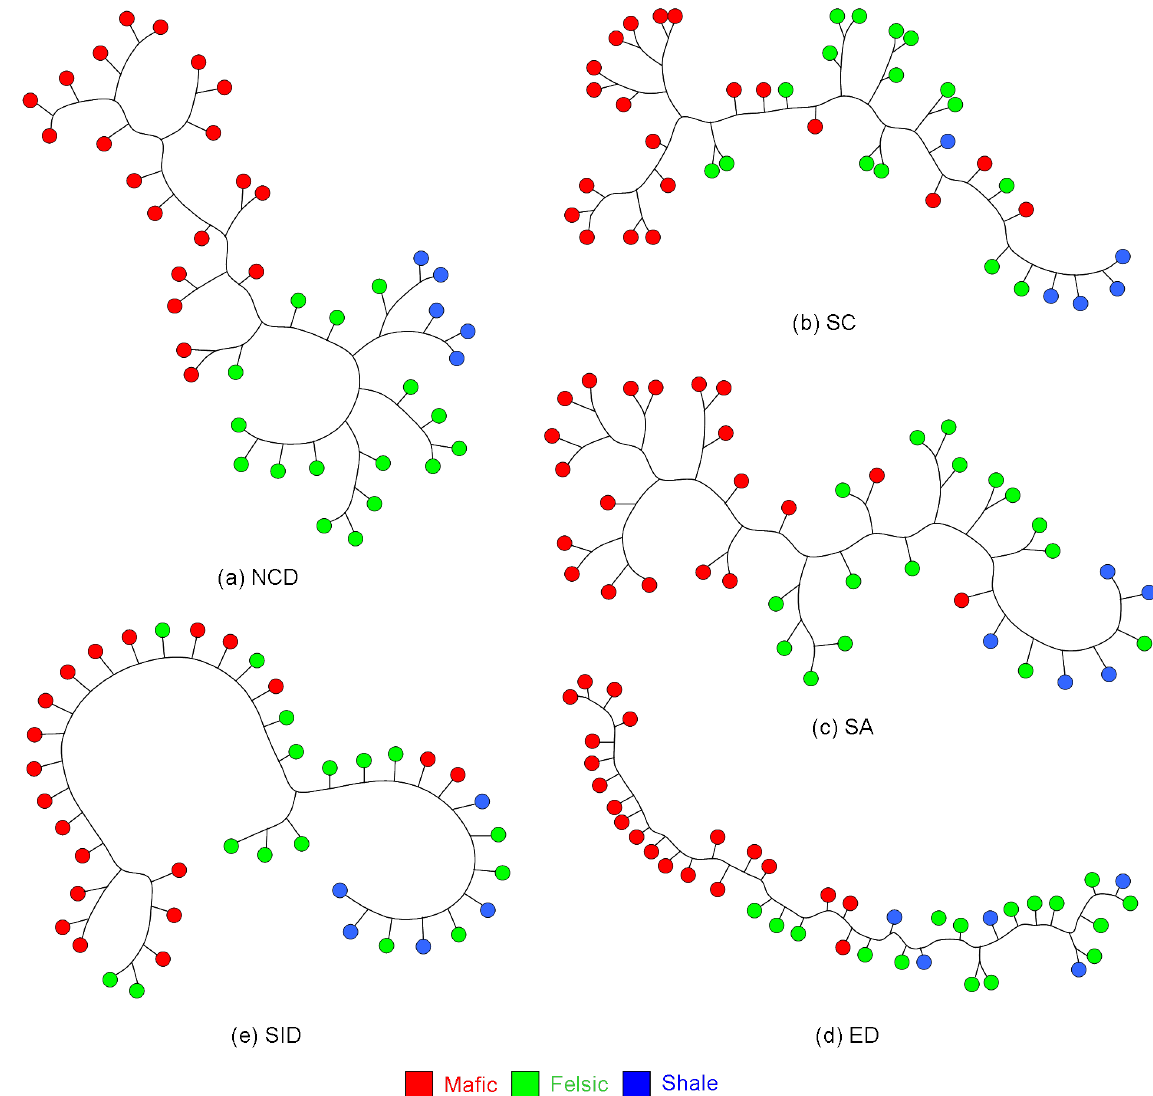
Figure 4: Hierarchical clusterings for the dataset in Fig. 3, with each node in the tree representing an object, color-coded as in the reported legend. From top-left in clockwise order: results for NCD, SC, SA, ED, and SID